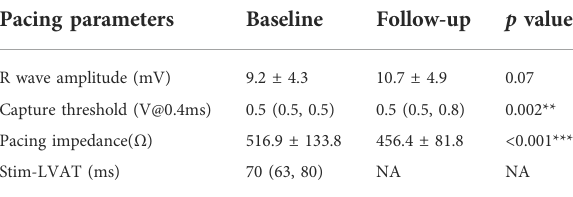
TABLE 1 Baseline characteristics of study population. TABLE 2 Procedure characteristics ( n =